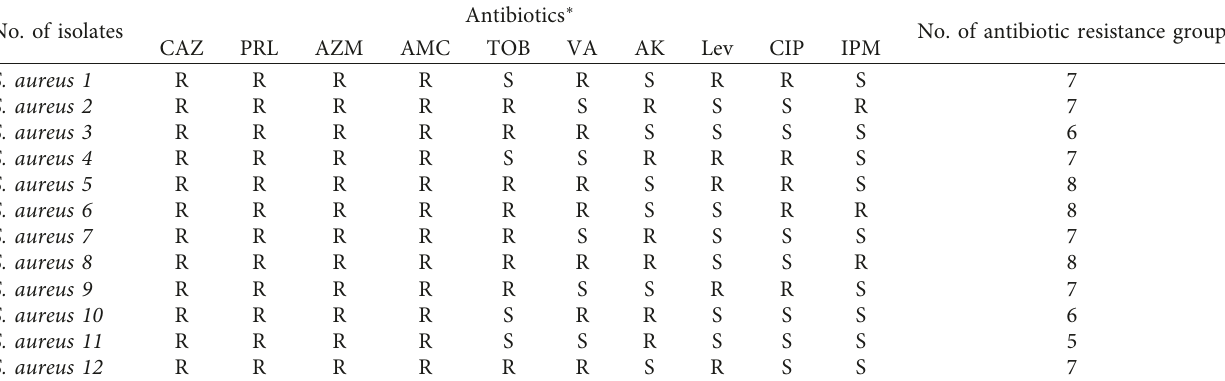
Table 5: Sensitivity of the 12 S. aureus isolates to antibiotics.